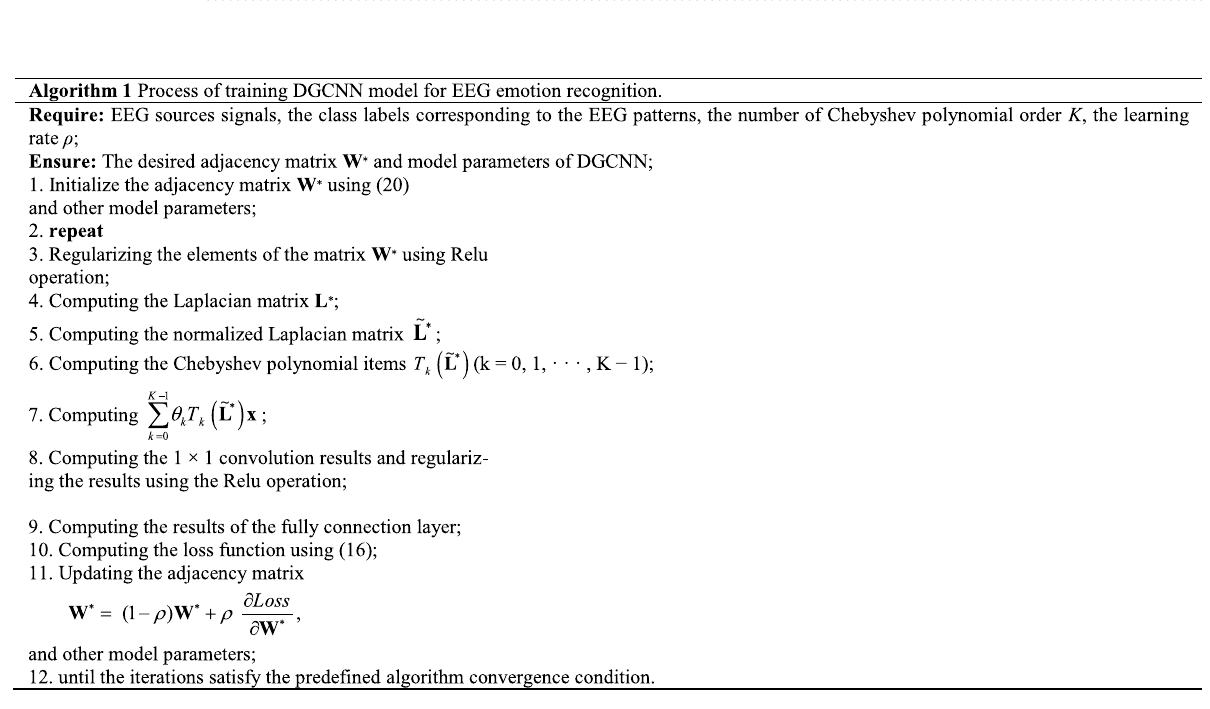
Figure 6. The framework of the DGCNN model for EEG emotion recognition, which consists of the graph convolutional operation, activation function and a fully connected layer. The inputs of the model are the EEG source signals, where each EEG source signal is represented as a node of the graph. The outputs are the predicted labels through softmax